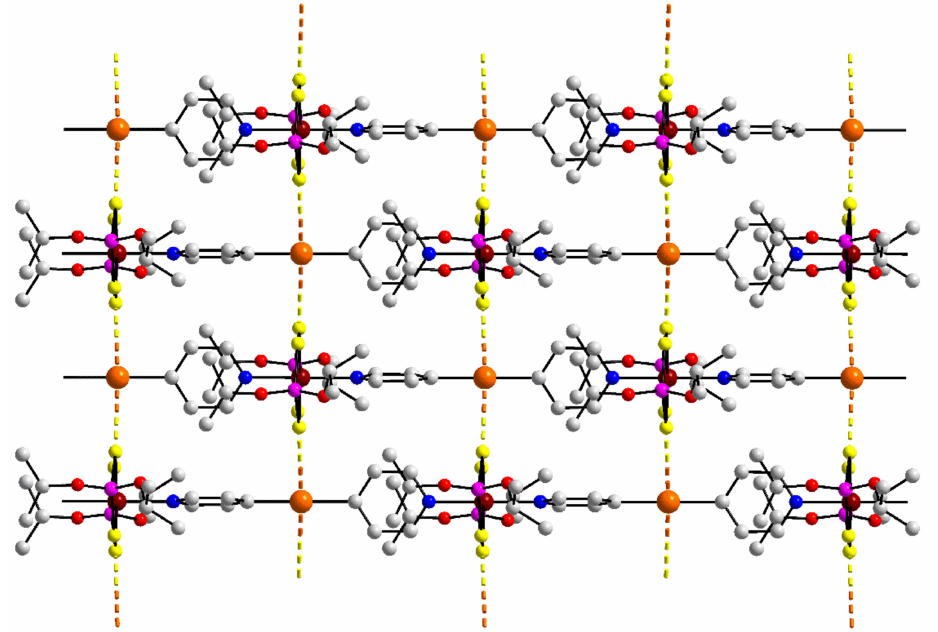
Figure 25. Supramolecular layer in the crystal of 62 whereby a heterometallic coordination polymer is linked into a two-dimensional array by Hg ··· S